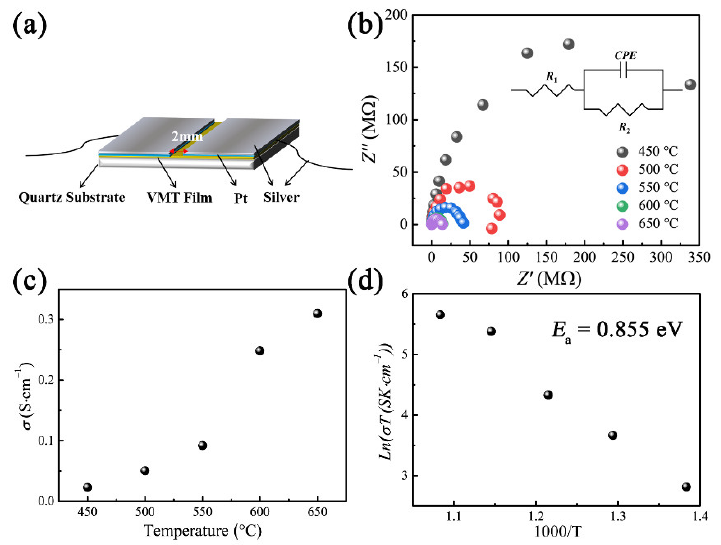
Figure 5. Schematic illustration of the device for the electrical measurement of the IEVMT film ( a ), Nyquist plots ( b ), ionic conductivity ( c ), and Arrhenius plot ( d ) of IEVMT film.